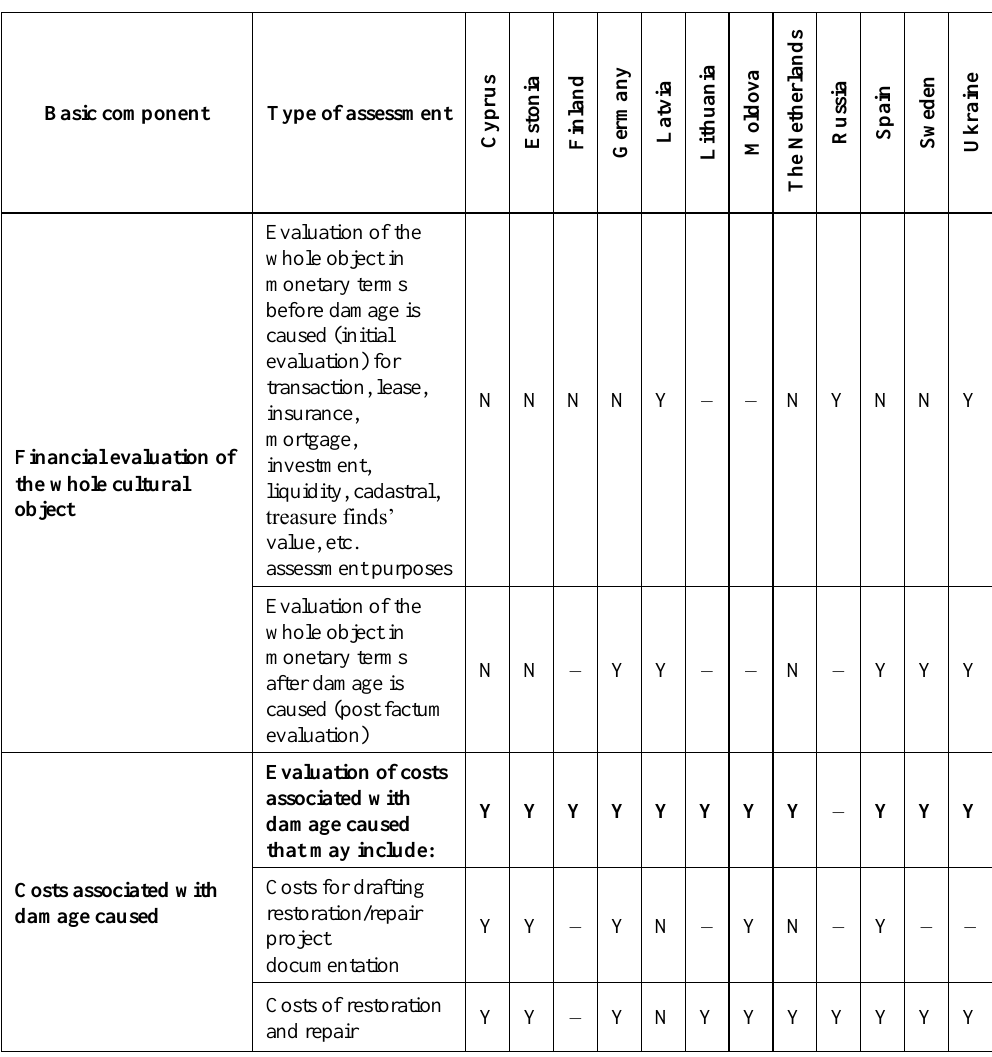
Table 3. Examples of Components for Assessment of Damage Done to Cultural